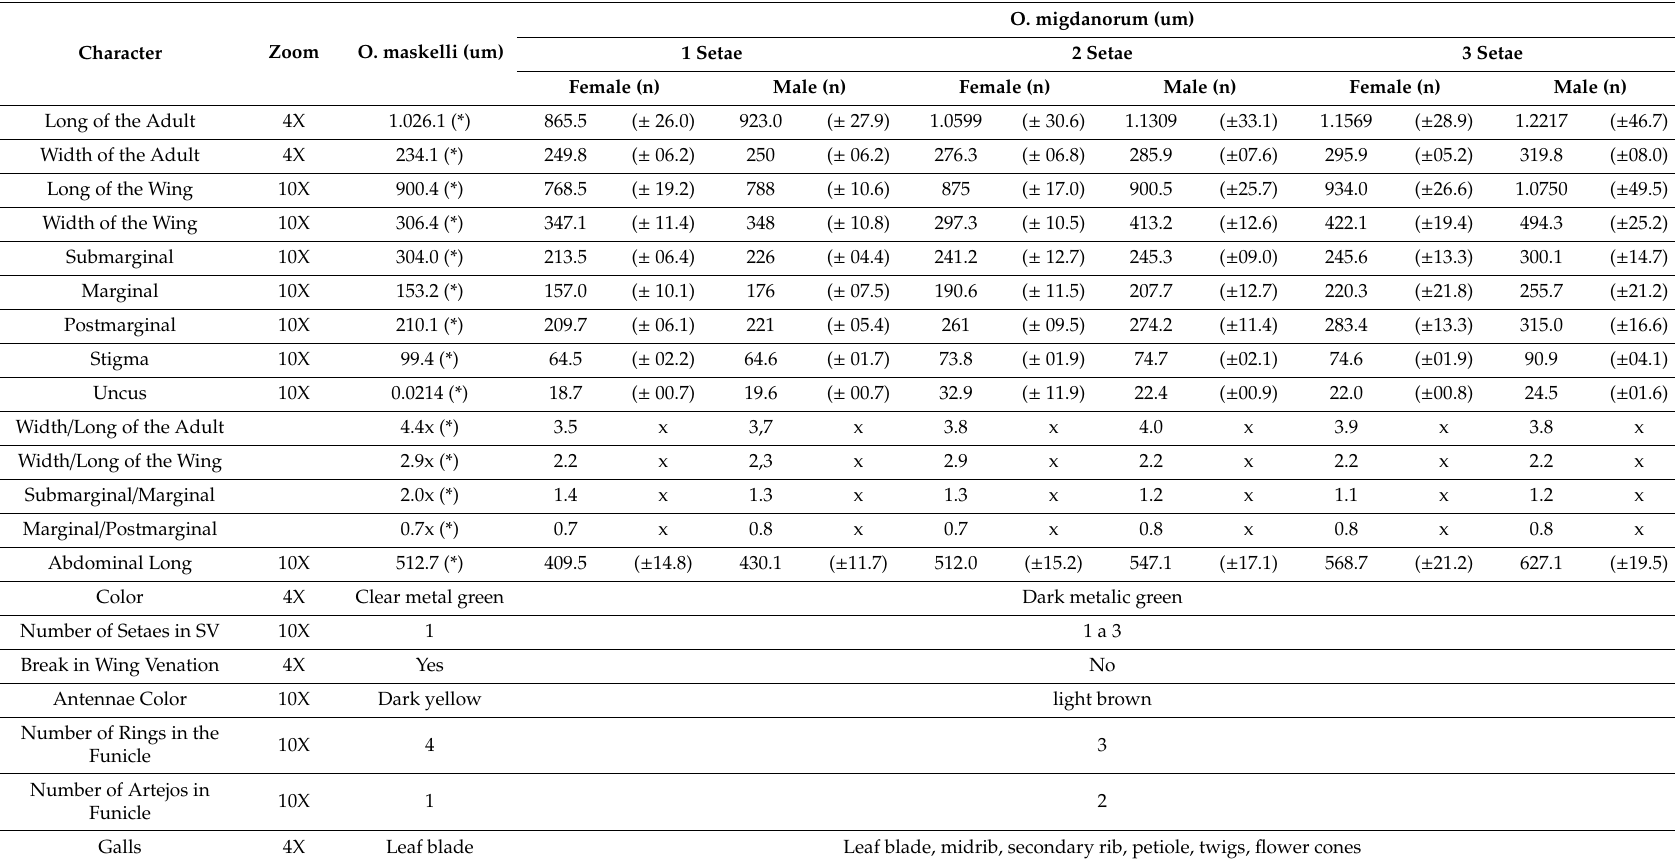
Table 3. Comparison of Ophelimus migdanorum with Ophelimus maskelli based on Protasov et al. [6] and La Salle